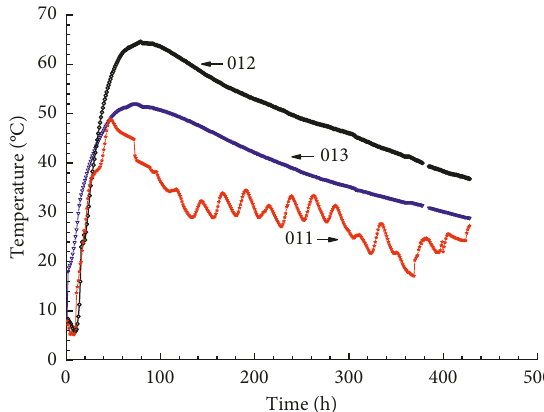
Figure 4: Measured temperature evolution of Points 001–005.